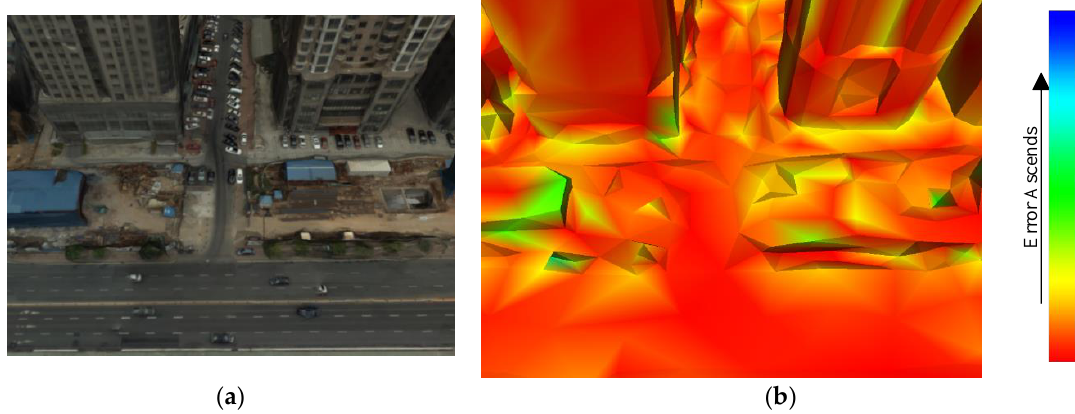
Figure 2. Effect of color mapping, a function of Metro [20]. It is clearly seen that major error is located on nonplanar surfaces for sharp features, such as the edges and corners of buildings. However, these urban frameworks are essential for the applications of urban surfaces, as mentioned above. ( a ) Input surfaces with texture; ( b ) Simplified surfaces after error mapping.